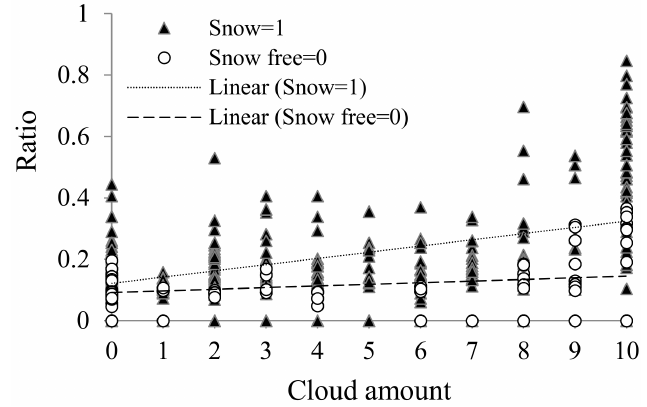
Figure 2. Correlation between ratio of the reflected irradiance to the irradiance on the front inclined plate and cloud